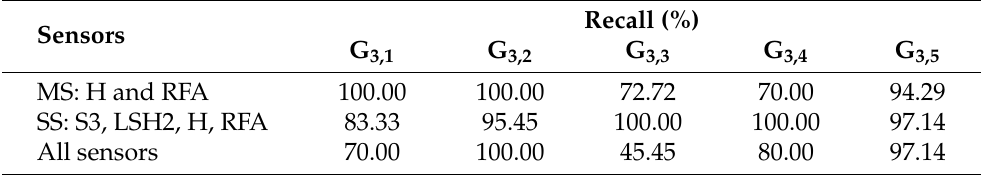
Table 10. Recall achieved for G 3 using